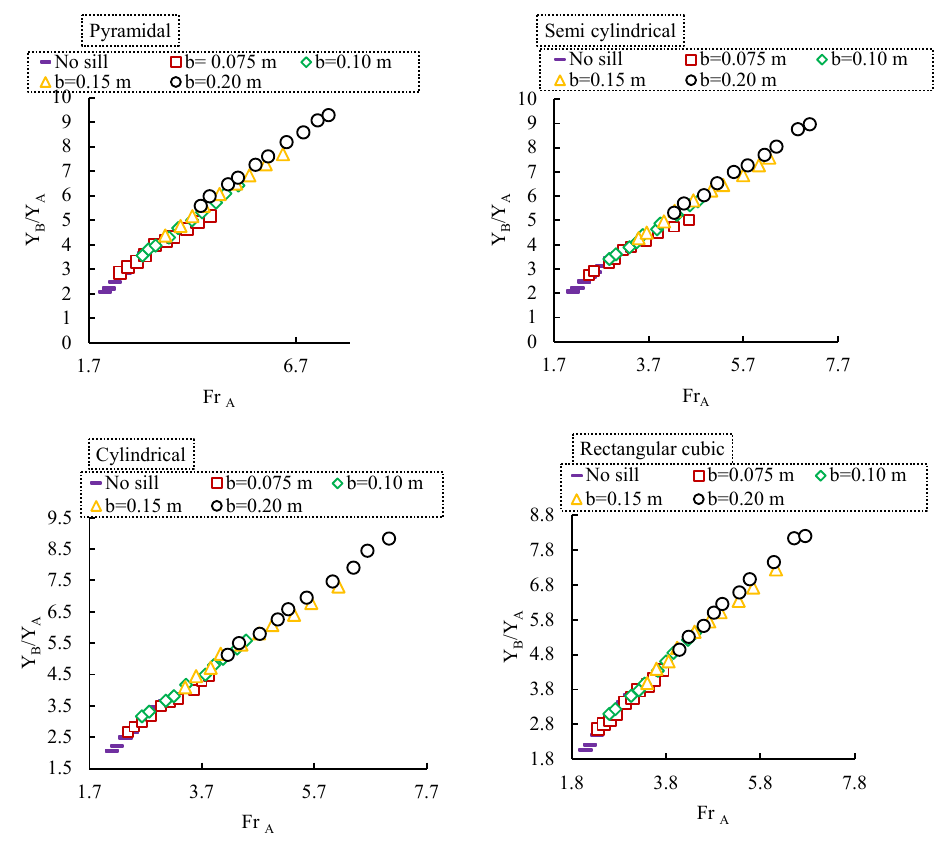
Figure 8 . Effect of sill width on hydraulic depths. Figure 8. Effect of sill width on hydraulic depths.